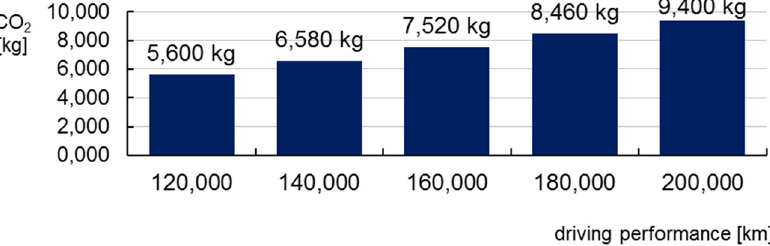
Figure 4: Di ff erence in CO 2 production between the compared tractors with semi - trailers depending on the annual driving performance in